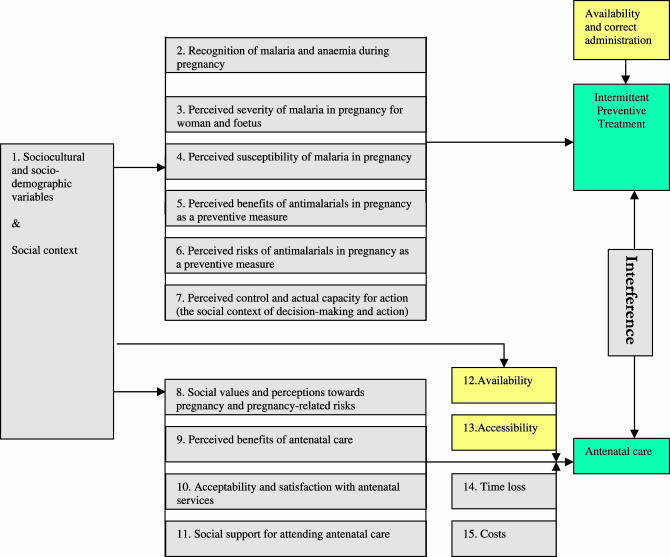
The Malaria in Pregnancy Prevention Model: Relevant Factors for the Utilization of ANCs and Acceptance of IPT